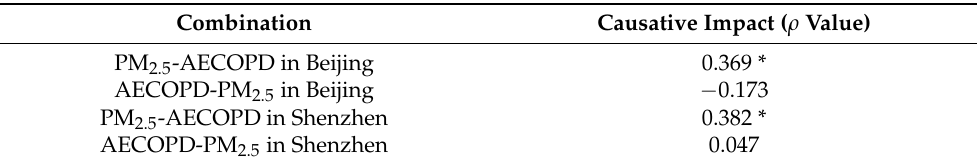
Table 4. Numerical result of causality ( ρ value) between PM 2.5 and AECOPD in Beijing urban areas and Shenzhen City. (Value with * is significant at the 0.05